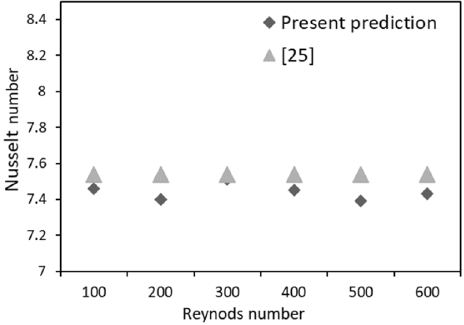
Fig. 6 The relative friction coefficient versus Reynolds number in the channel with simple baffle and different BRs (BR = 0.2, 0.4, and 0.6, θ = 90°)